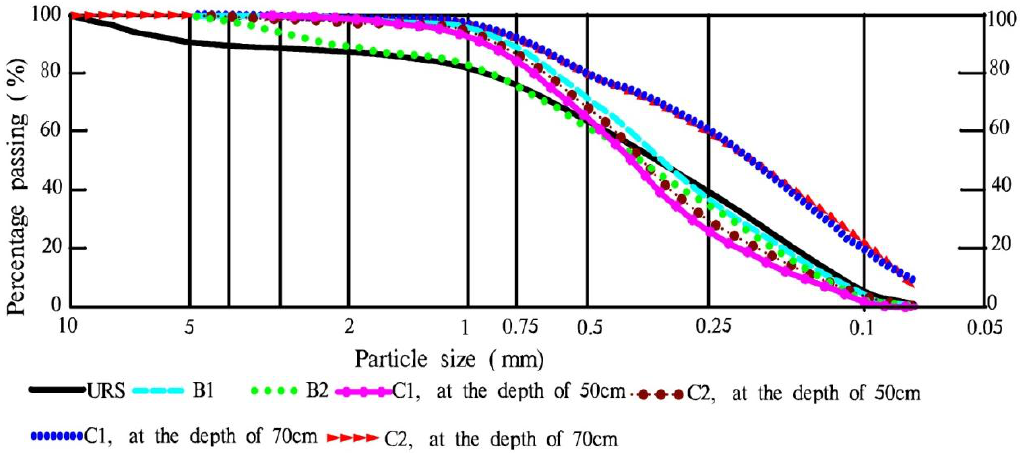
Figure 16. Accumulative curve of particle gradation of soil at the sampling depths of 50 cm and 70 cm.